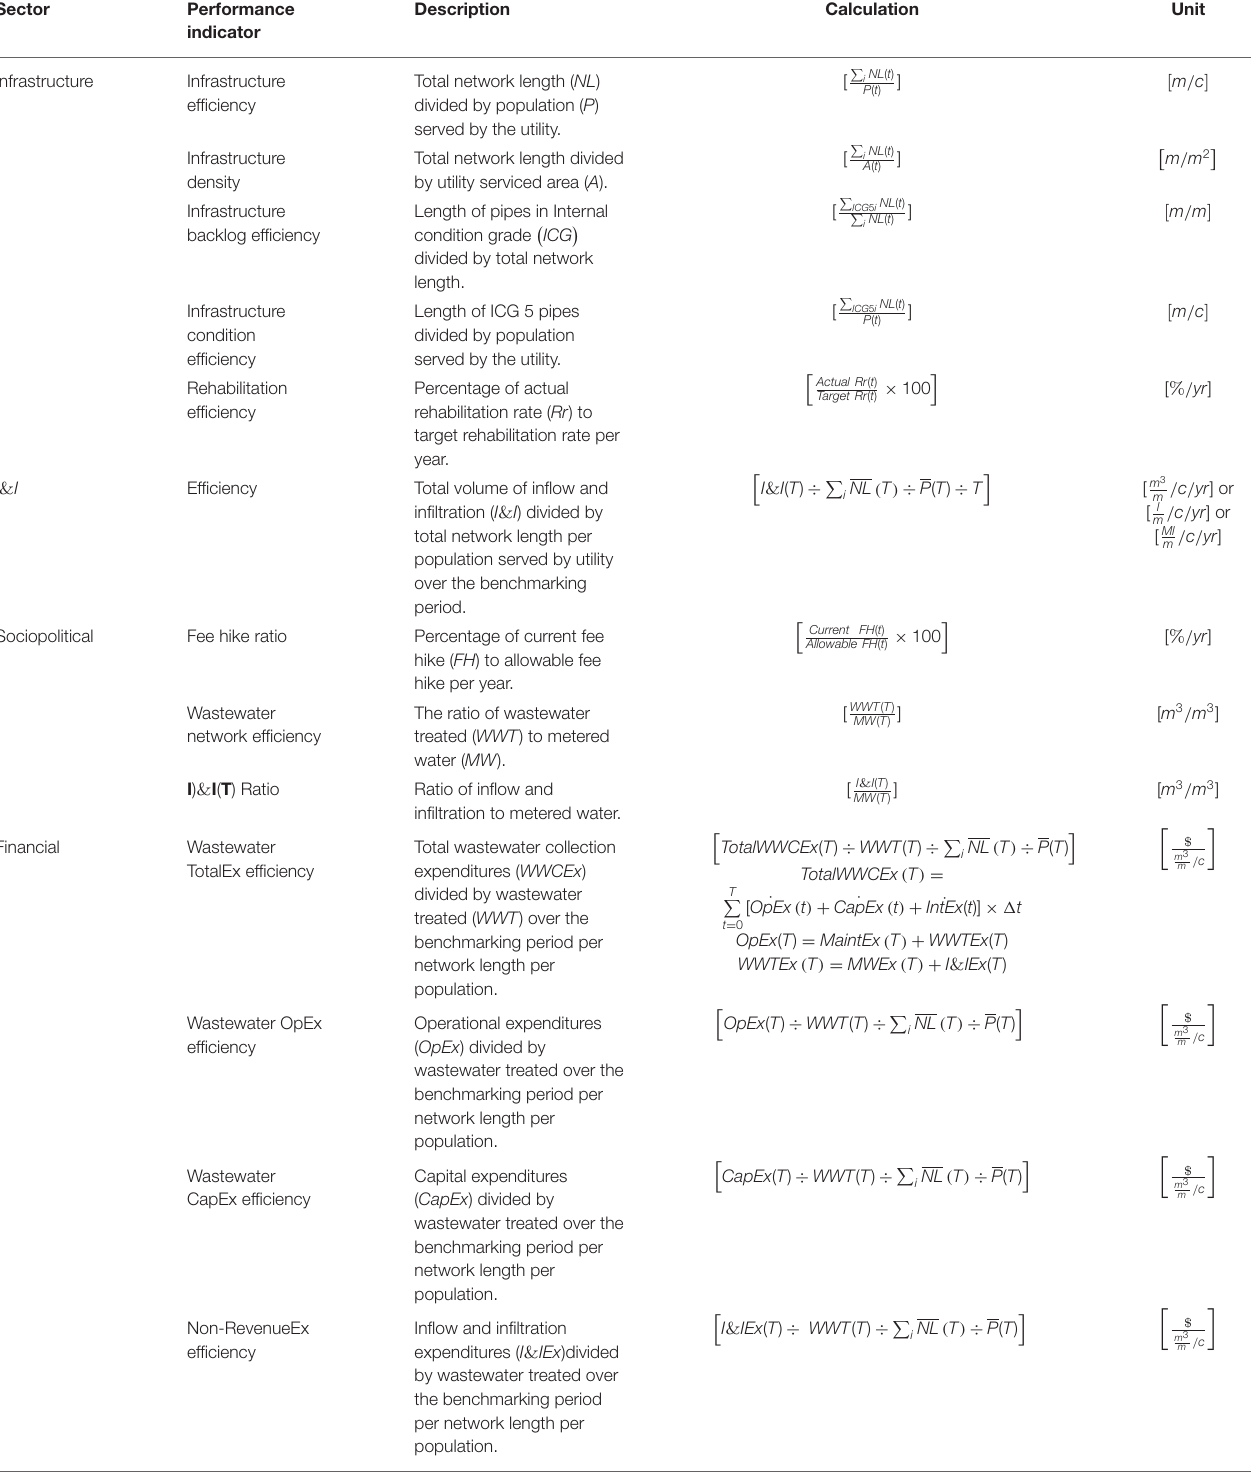
TABLE 1 | Benchmarking performance indicators for wastewater collection networks - adopted from Ganjidoost et al. (2018). Sector Performance